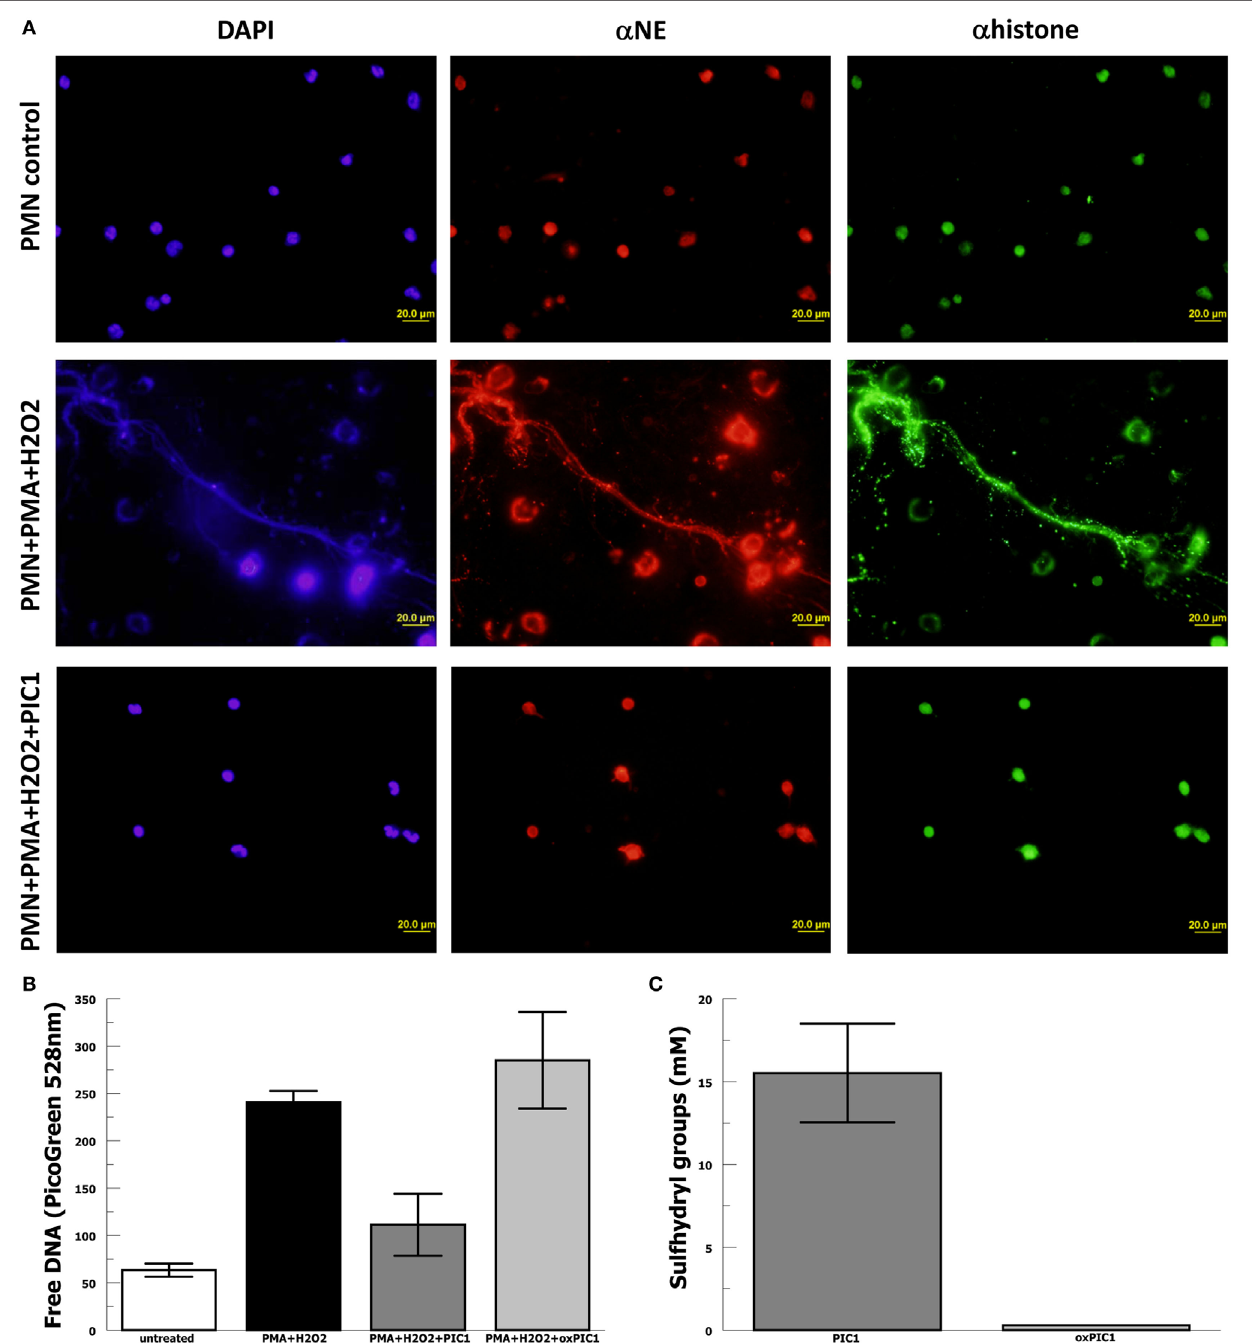
FigUre 5 | PA-dPEG24 inhibition of PMA-initiated neutrophil extracellular trap (NET) formation with human neutrophils (PMN). (a) PA-dPEG24 inhibition of PMA-initiated NET formation assayed by fluorescence microscopy for DNA (DAPI), neutrophil elastase ( α NE), and histone H3 ( α histone). The first row shows unstimulated neutrophils, the second row shows neutrophils stimulated with PMA and hydrogen peroxide (H 2 O 2 ), and third row shows neutrophils stimulated with PMA + H 2 O 2 in the presence of 5 mM PA-dPEG24 peptide inhibitor of complement C1. The first columns are slides probed with DAPI to visualize DNA, the second columns are slides probed with anti- α NE antibody, and the third row is probed with anti-histone H3 antibody. Representative images are shown. (B) Oxidized PA-dPEG24 [ox peptide inhibitor of complement C1 (PIC1)] demonstrates no activity in the PMA-initiated NET assay by measuring free DNA with PicoGreen. Data are means of ( n = 3) independent experiments ± SEM. (c) Oxidation of the sulfhydryl groups of PA-dPEG24 (oxPIC1) demonstrated with Ellman’s reagent. Data are means of ( n = 3) independent experiments ±